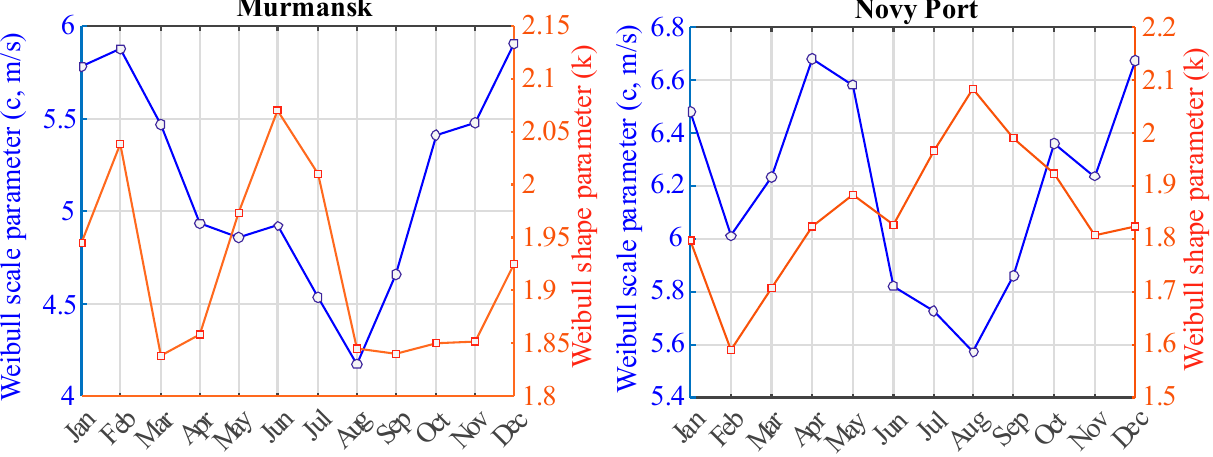
Figure 5. Month-wise Weibull distribution parameter estimates. The wind speed data was simulated on a time interval equal to 20 years, with a sampling step equal to the initial interval between observations ( ∆ t = 3 h) and with an hourly interval ( Δ t = 1 h). For the simulated time series of wind speed, the hourly autocorrelation, autocorrelation of daily average values during the year, and daily profiles and histograms of probability distribution were compared with same characteristics of actual data.